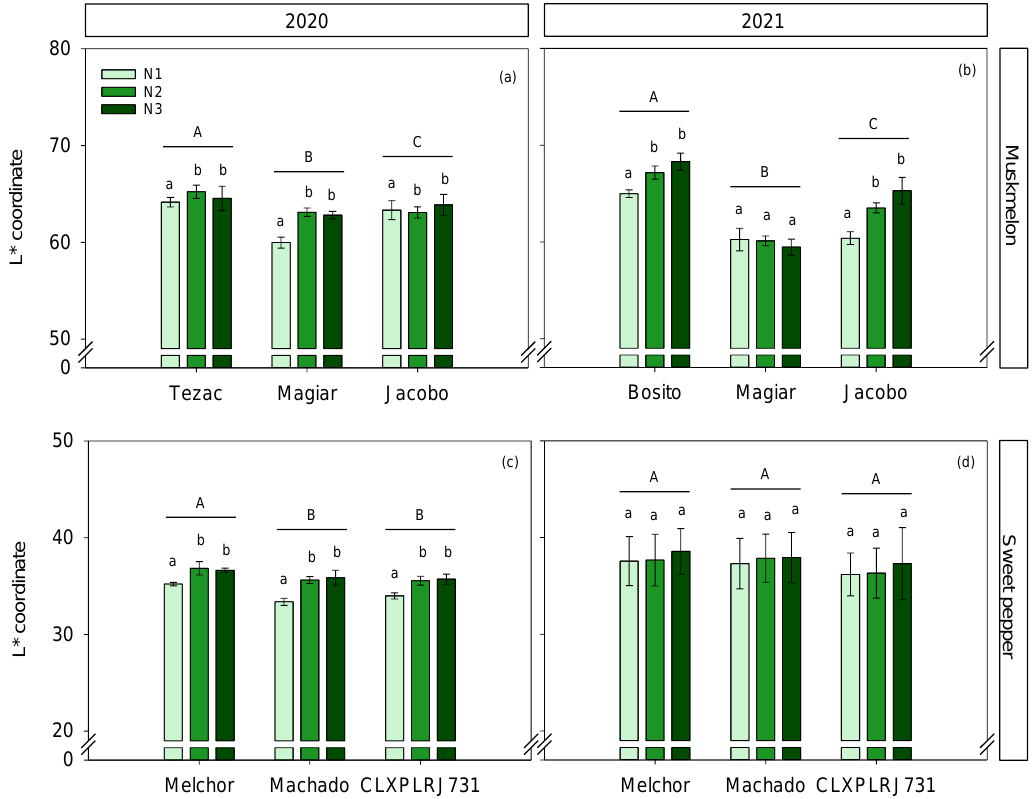
Figure 5. Fruit L* (lightness) for three cultivars and three N treatments, for muskmelon ( a , b ) and sweet pepper ( c , d ) crops, conducted in 2020 and 2021 years. Fruit measurements are internal for muskmelon and external for sweet pepper. Different lowercase letters show significant differences between N treatments within each cultivar; different uppercase letters show significant differences between cultivars. Values are means ± SE.